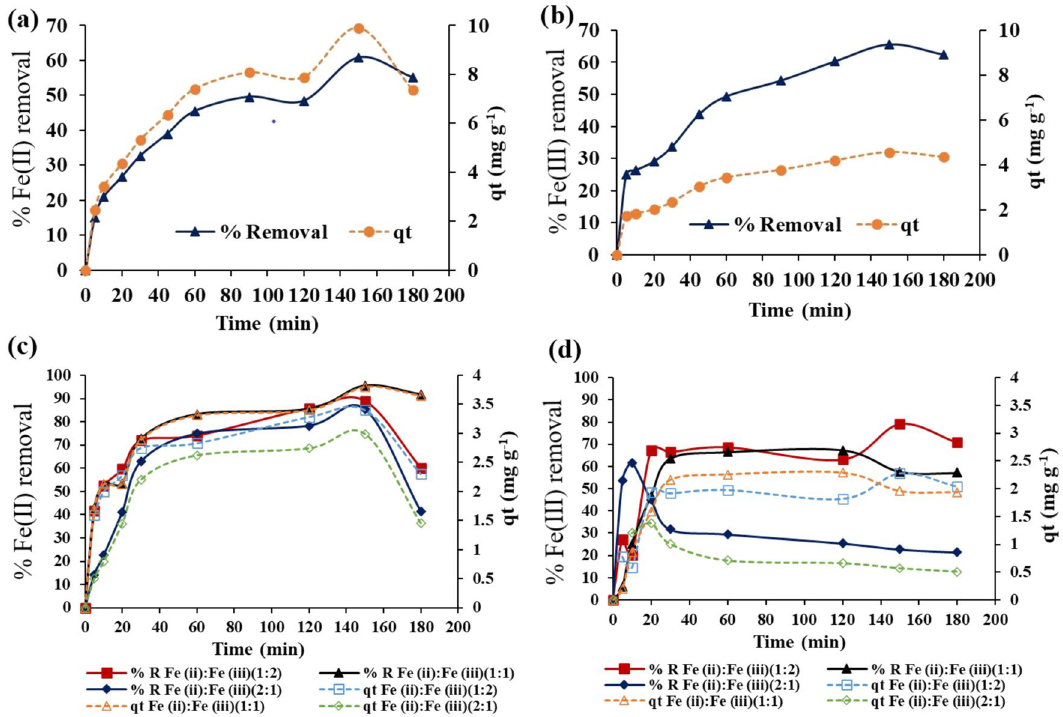
Figure 5. Effect of contact time on the percentage removal (%) and the adsorbed amount (q t , mg g −1 ) of Fe(II) and Fe(III) from single ( a ),( b ) and binary systems ( c ),( d ) using cellulose nanocrystals/graphene oxide